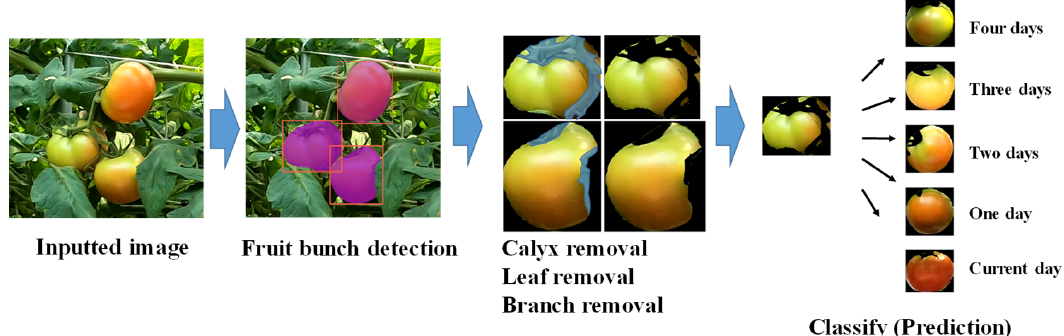
Figure 1. Flow of harvesting time prediction.